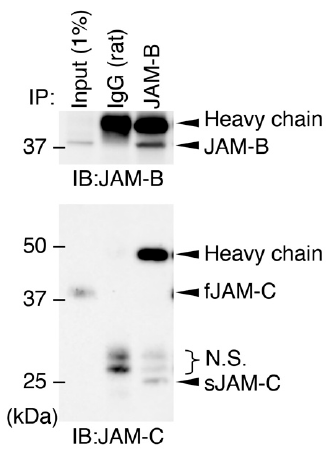
Figure 6. Association between soluble JAM-C and full-length JAM-B on ADSCs. Whole-cell lysates (1% of the input protein samples) and the samples immunoprecipitated (IP) with IgG or JAM-B Ab were immunoblotted (IB) with the indicated Abs. N.S., nonspecific signals.